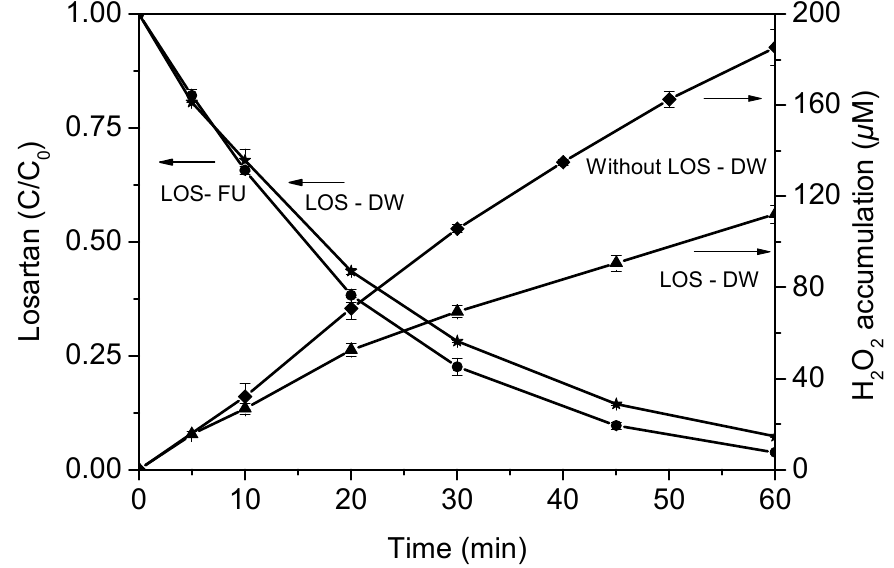
Figure 3. Determination of action routes of the sonochemical treatment on losartan in distilled water (DW) and fresh urine (FU). Conditions: [LOS] = 43.38 µM, 106.3 W L − 1 (375 kHz), pH = 6.1.